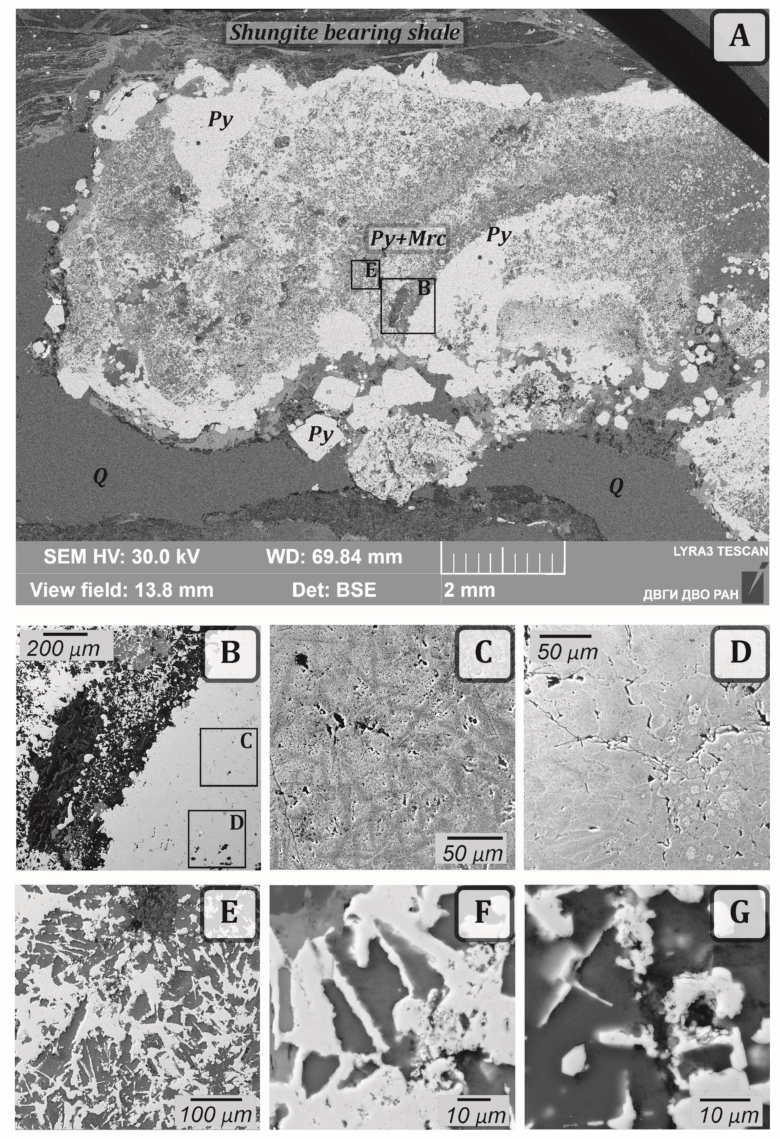
Figure A3. Collomorphous pyrite, BSE image ( A – E ). Laminated aggregate bordered with carbona- ceous shale. It should be noted that parts ( F , G ) are outside of part ( A